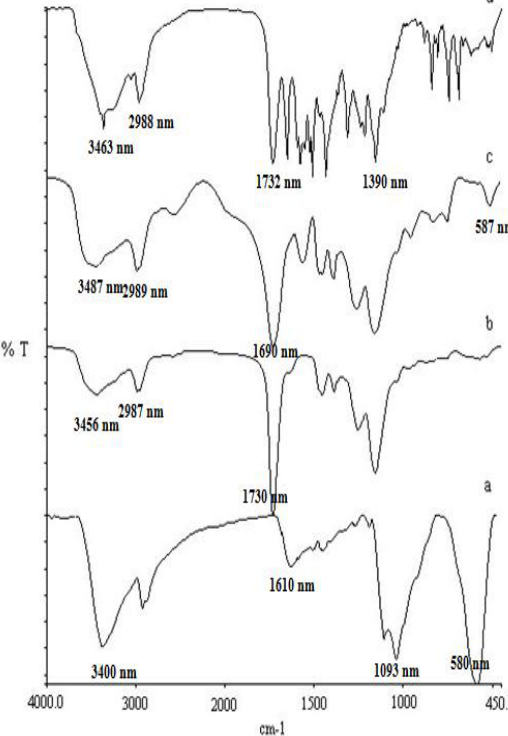
Fig. 4. FT-IR spectra of (a) APTS coated MNPs (b) nano-carrier (c) plain polymer and (d) atorvastatin loaded